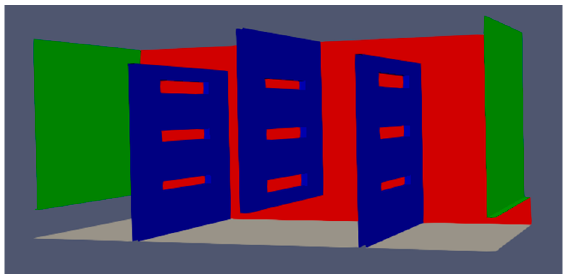
Figure 8. Typical contact tank baffle configuration for baffles with slots (w = 120 mm, h = 10, 12, 14 mm random) case.